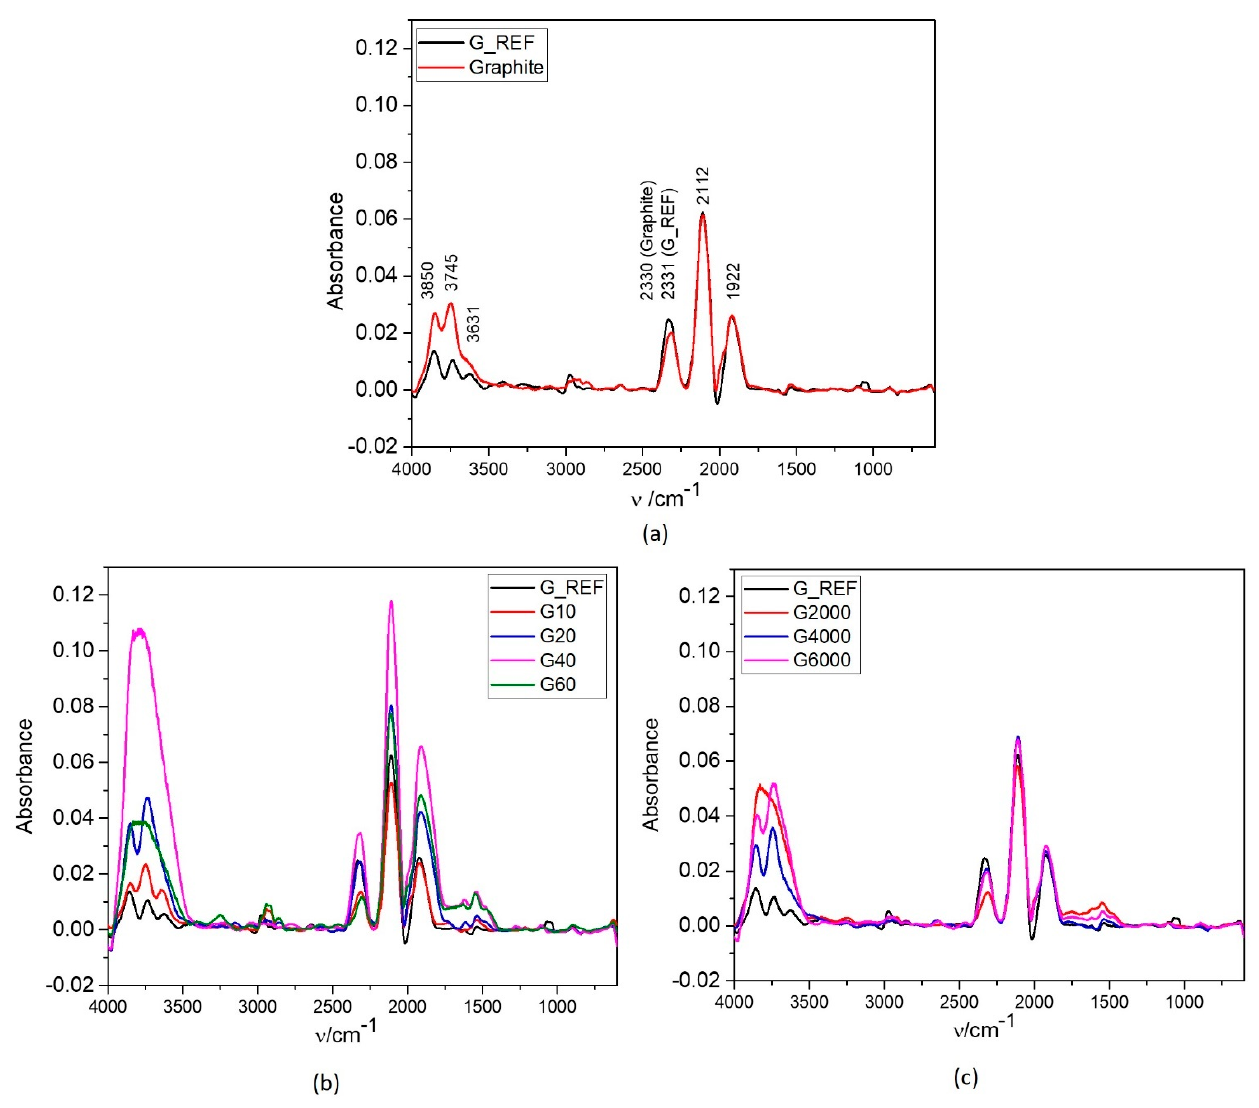
Figure 4. ATR − IR spectrum of commercial graphene (G_REF), commercial graphite ( a ), and modified graphene samples through the two different ball milling processes ( b , c ).